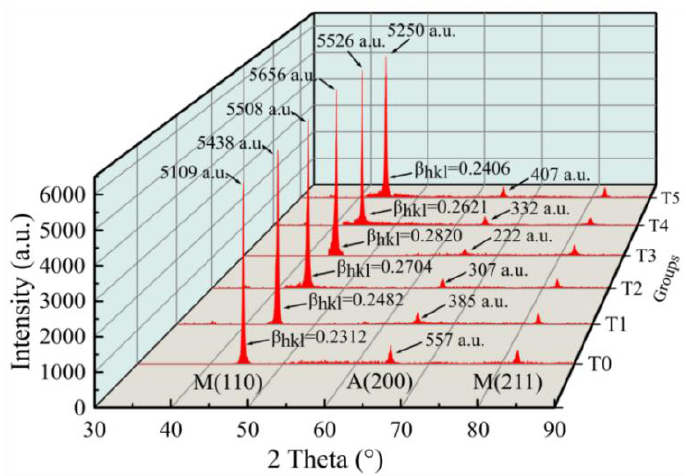
Figure 5. X-ray diffraction pattern on the specimen surface layer of groups T0 – T5. The grain size etching results of the samples are shown in Figure 6. It is not difficult to notice that the grain size of the control group T0 was the largest and distributed equally, while that of the group T1-T5 samples treated by the SMGT was reduced compared to that of the control group. With the jet angle of the SMGT rising from 0.2 MPa to 0.6 MPa, the uniformity degree of the grain size on the processed surface of the tested samples is reduced. Meanwhile, the uniformity degree of the grain size is also reduced as the jet angle rises from 30 ◦ to 90 ◦ . This indicates that, compared with the control group T0, the grain size of the surface layer on the samples treated with the SMGT was refined.